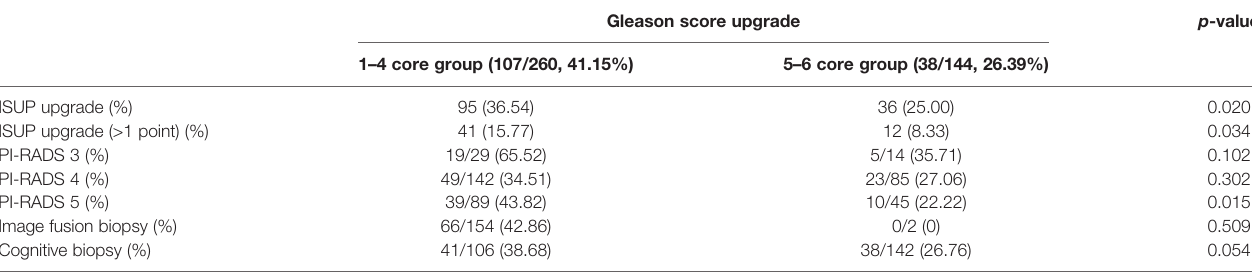
TABLE 4 | Sub-analysis of Gleason score